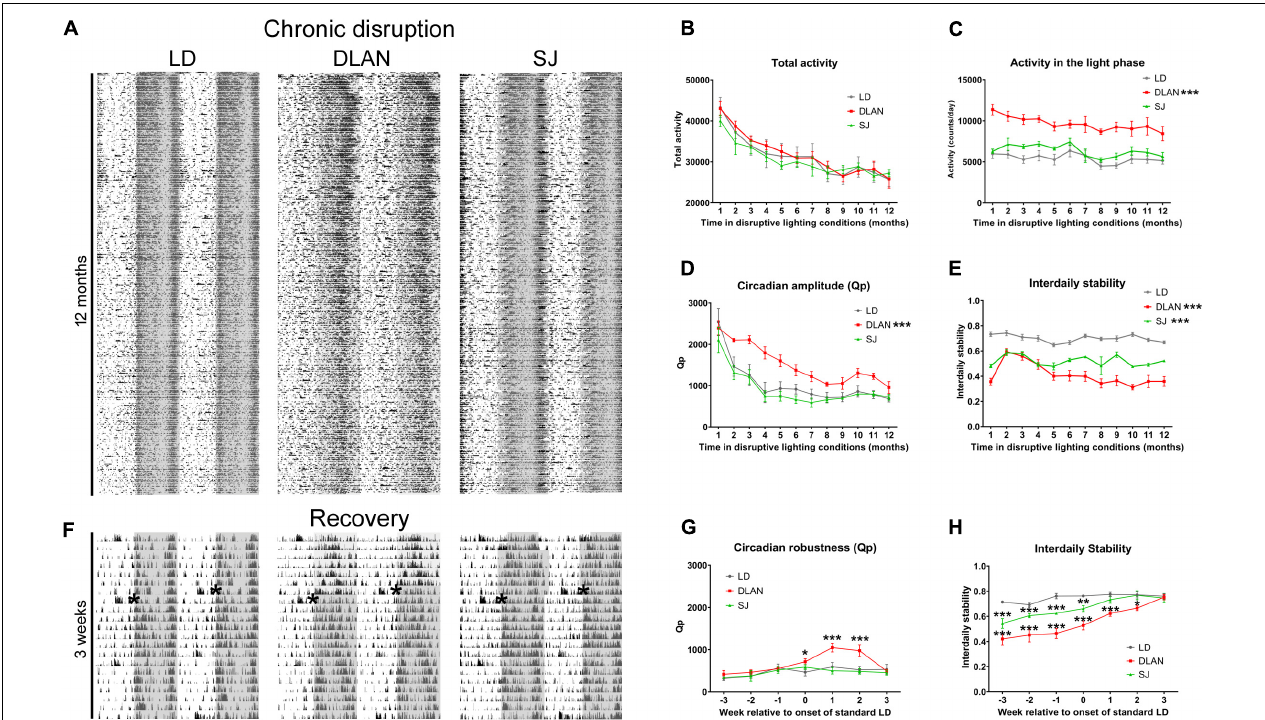
FIGURE 2 | Passive infrared recordings (PIR) monitoring during the 12-month lighting disruption period. (A) Representative actograms of group-housed mouse activity throughout the 12-month period of disruptive lighting. (B–E) Quantification of the PIR data over the 12 months of recording: total activity levels (B) , activity in the light phase (C) , circadian amplitude (Qp value) (D) , and interdaily stability (E) . (F) Representative actograms of the recovery period following the 12-month period of disruptive lighting. Actograms show the final week of activity under disruptive conditions and the following 2 weeks after return to standard LD conditions. Asterisks in the actograms of panel F denote the onset of standard LD conditions. (G,H) Quantification of PIR data of the recovery period: Qp (G) and interdaily stability (H) . Data is presented as mean ± SEM. Repeated measures ANOVA (with Welch correction), groups: LD, DLAN, SJ. Post-hoc tests conducted with Benjamini-Hochberg corrections. *** p < 0.001, ** p < 0.01, * p <